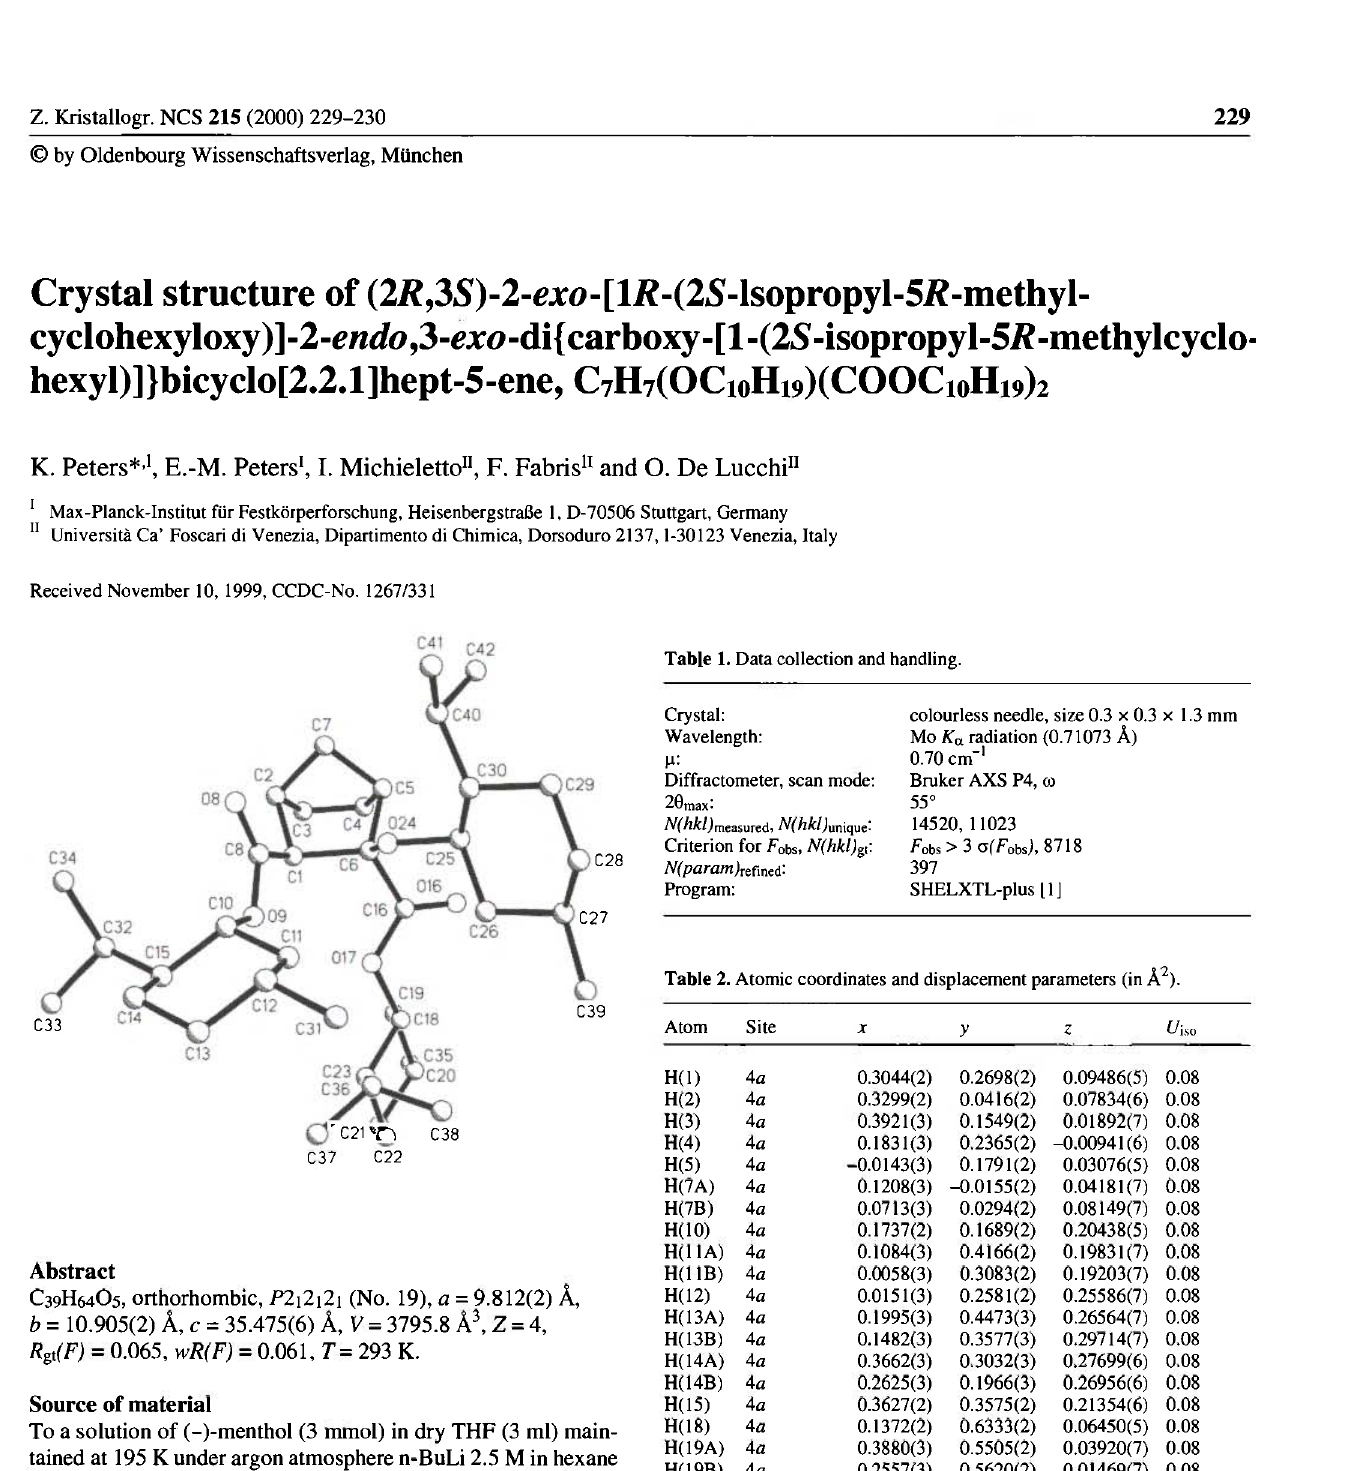
Table 2. Atomic coordinates and displacement parameters (in Ä 2